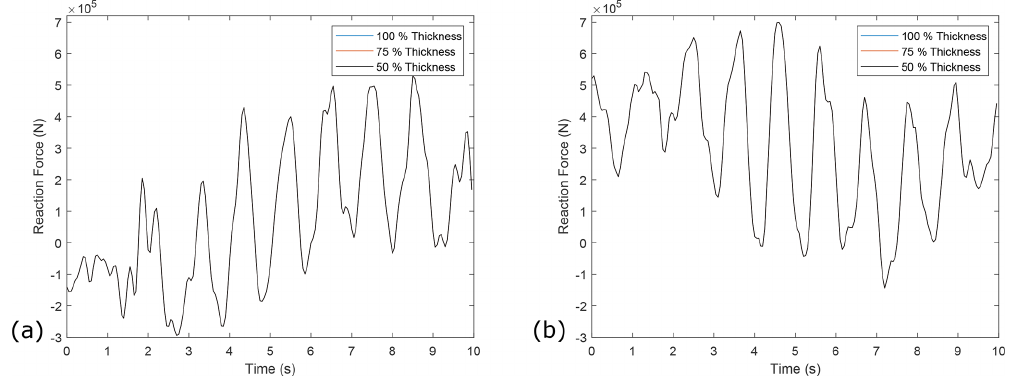
Figure B2. (a) Example time series of reaction force results in the horizontal plane from the FE DSRB model when the shaft thickness is altered. (b) Example time series of reaction force results in the vertical plane from the FE DSRB model when the shaft thickness is altered.